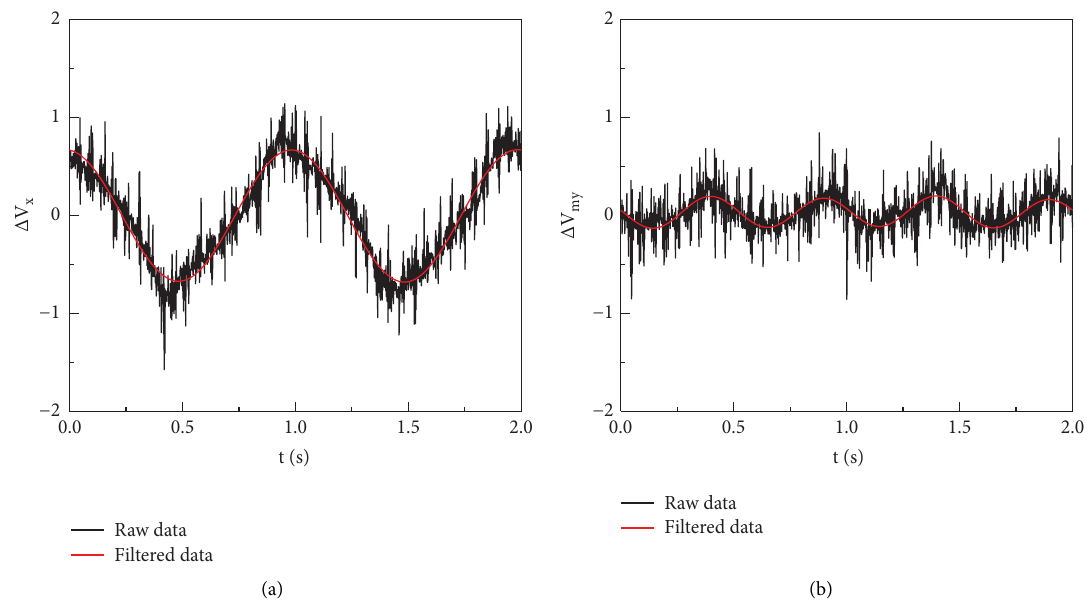
Figure 3: Raw and filtered voltage data of the balance output as a function of time (the zero-point reference set has been deducted). (a) Δ V x – t . (b) Δ V my – t .